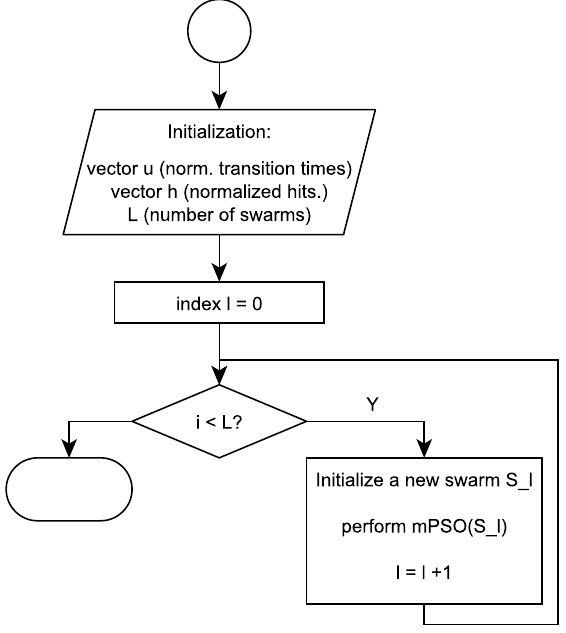
Figure 3. Flowchart of the whole modified Particle Swarm Optimization algoritm for all swarms. Fig. 4: Flowchart of the whole mPSO algorith for all swarms. Operation ‘mPSO( S l )’ Operation ‘ mPSO ( S l ) ’ executes the algorithm presented in Figure executes the algorithm presented in Fig. 5.